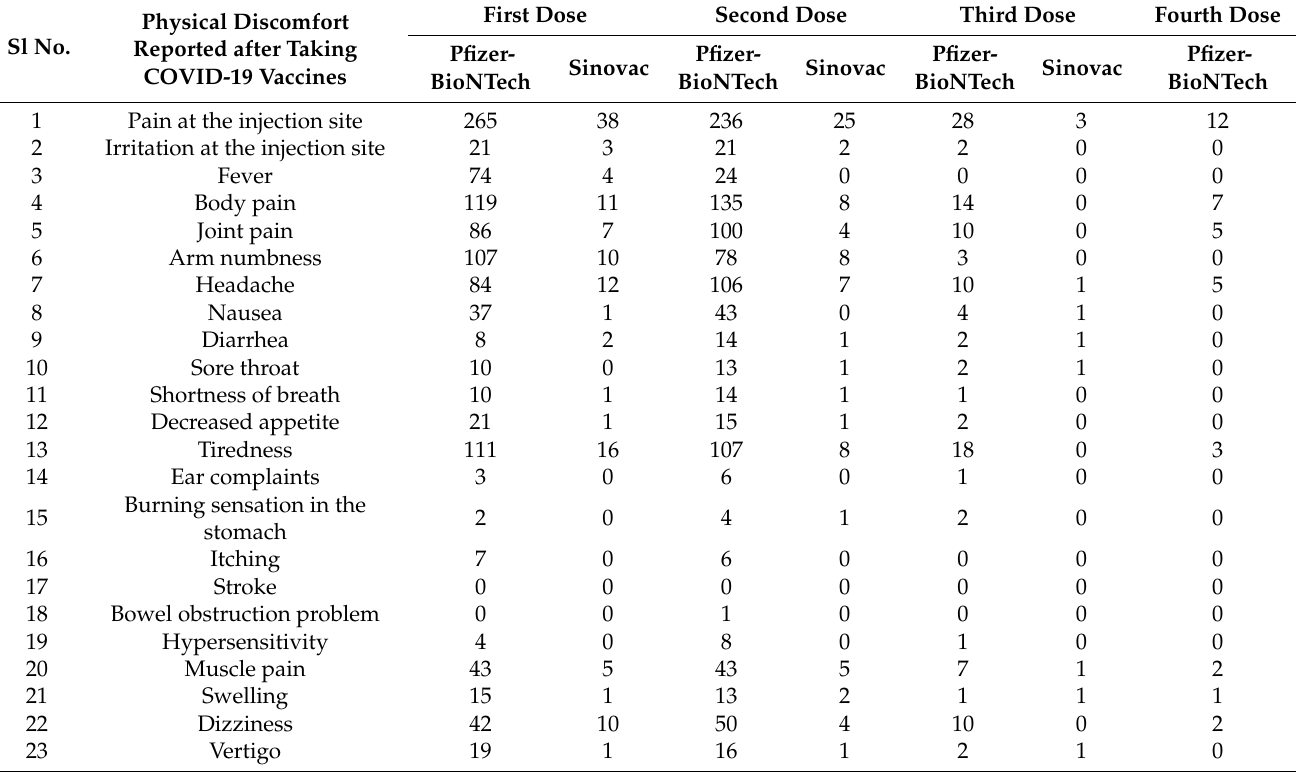
Table 5. Vaccine types and distribution of side effects after taking 1st, 2nd, 3rd, and 4th dose of